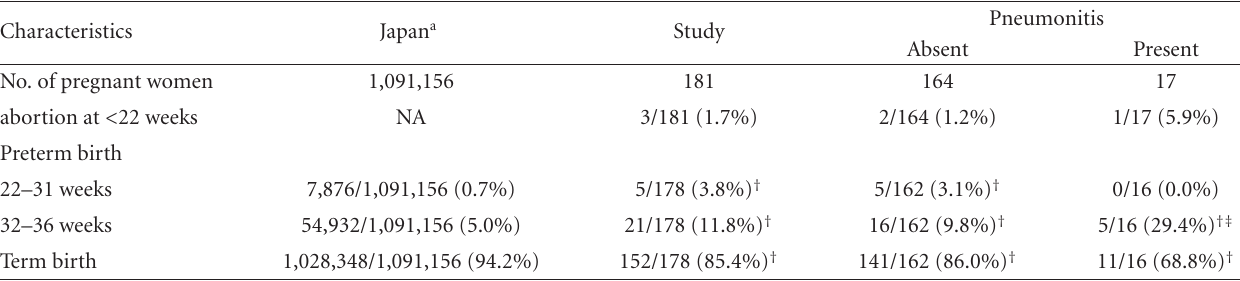
Table 3: Risk of preterm birth and abortion among 181 women who needed hospitalization for A(H1N1)pdm09 virus infection.